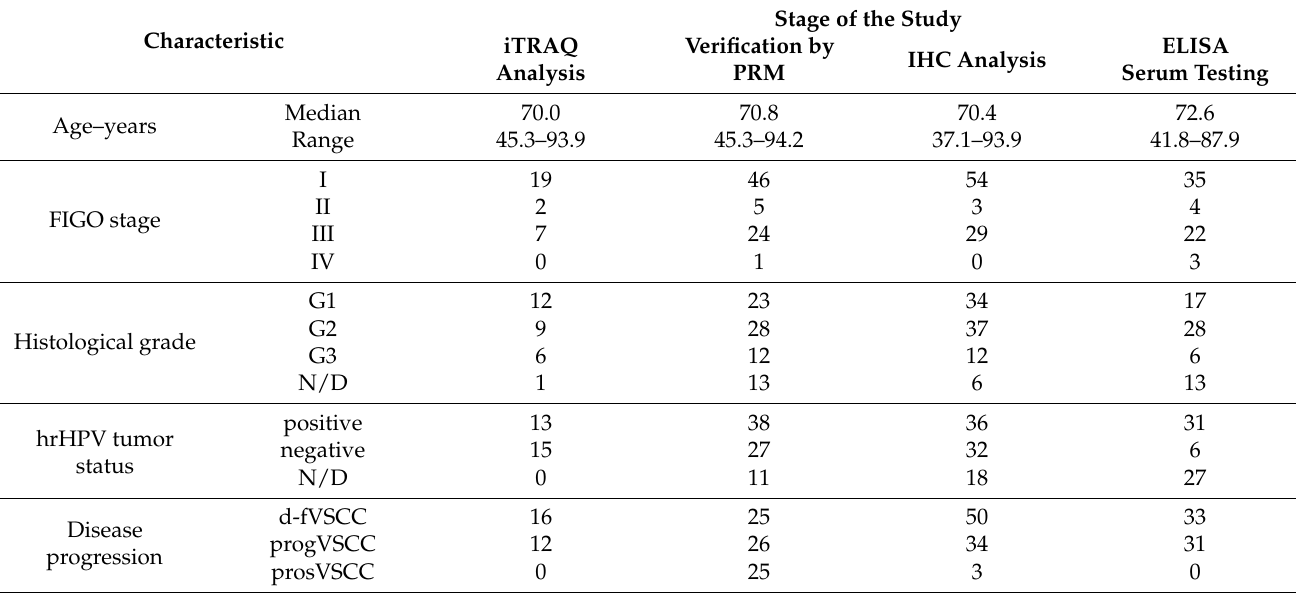
Basic characteristics of patients with primary VSCC (i.e., those from d-fVSCC, progVSCC, and prosVSCC groups) included are shown in Table 2. Table 2. Demographic and clinical characteristics of the patients with primary VSCC. Numbers of samples are provided for the consecutive phases of the